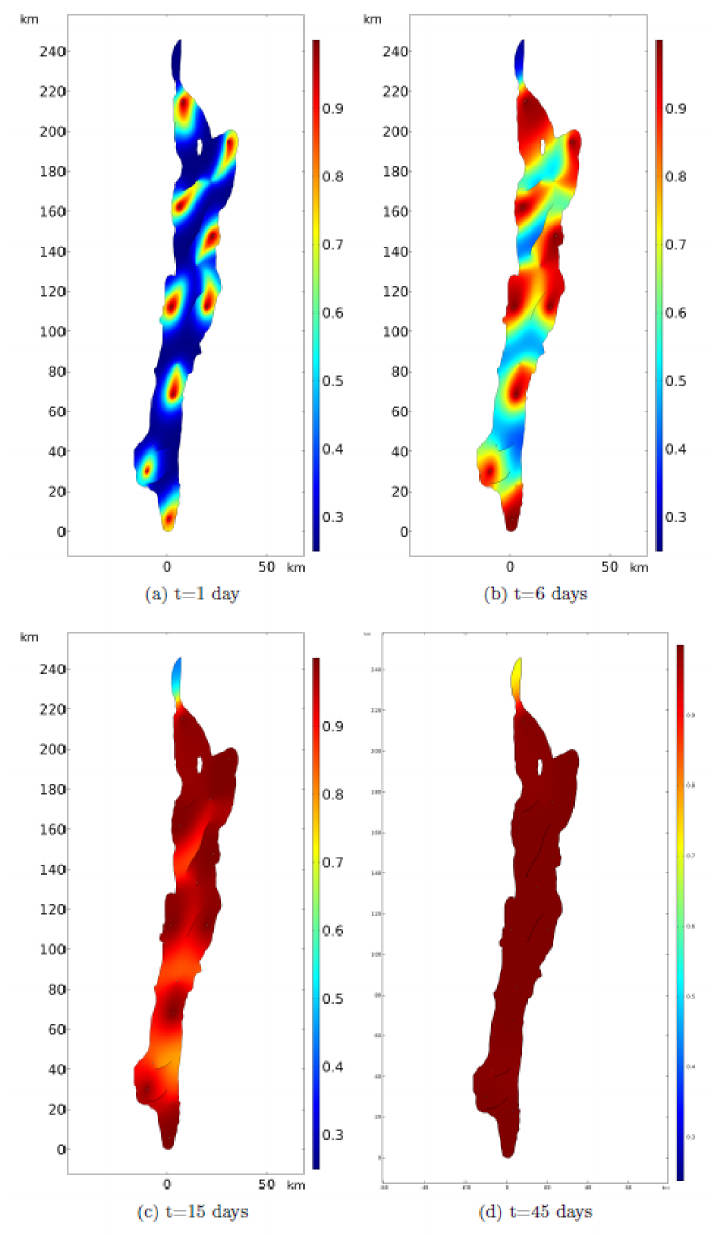
Figure 13. Normalized water saturation in the Ghawar field at four different time steps of the